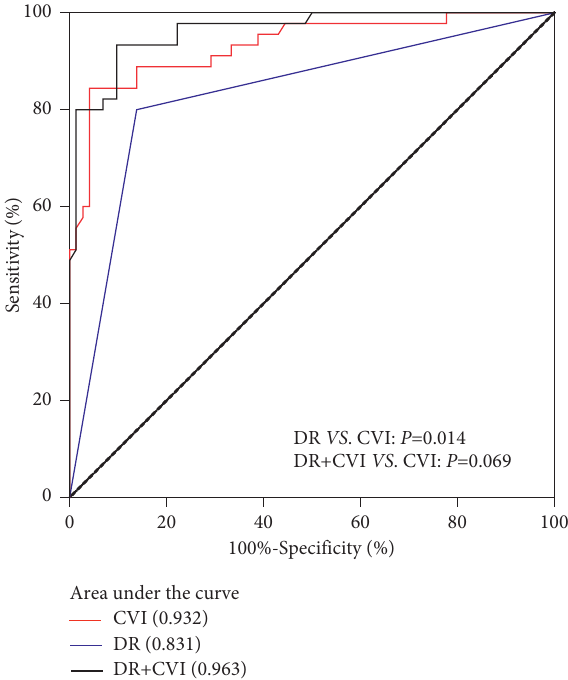
Figure 5: Receiver operating characteristic curves (ROCs) of the CVI, DR, and the CVI combined with DR to identify participants with DN. CVI: choroidal vascularity index; DR: diabetic retinop- athy; DN: diabetic nephropathy.